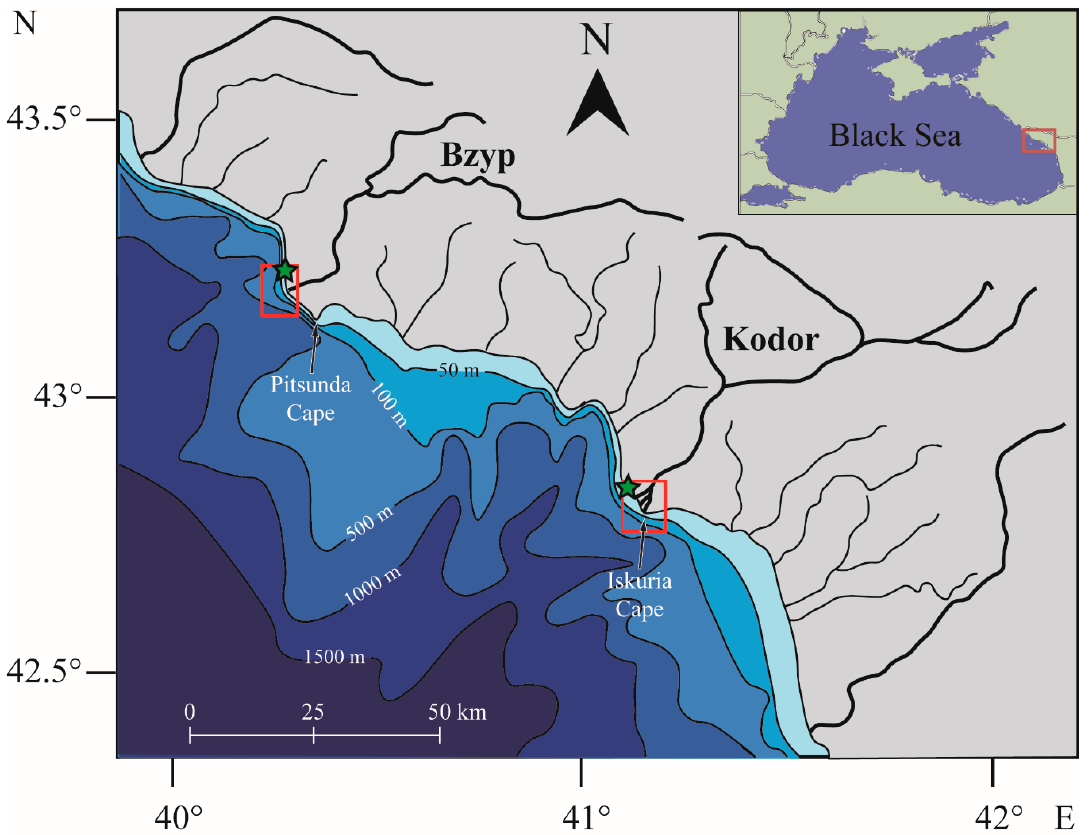
Figure 1. Bathymetry of the study region, locations of the Iskuria and Pitsunda capes, the Bzyp and Kodor rivers, and other smaller rivers of the study region. Location of the study region at the northeastern part of the Black Sea is shown in the inset. Red boxes indicate areas of aerial observations and in situ measurements at the Bzyp and Kodor plumes. Green stars indicate locations of meteorological stations.